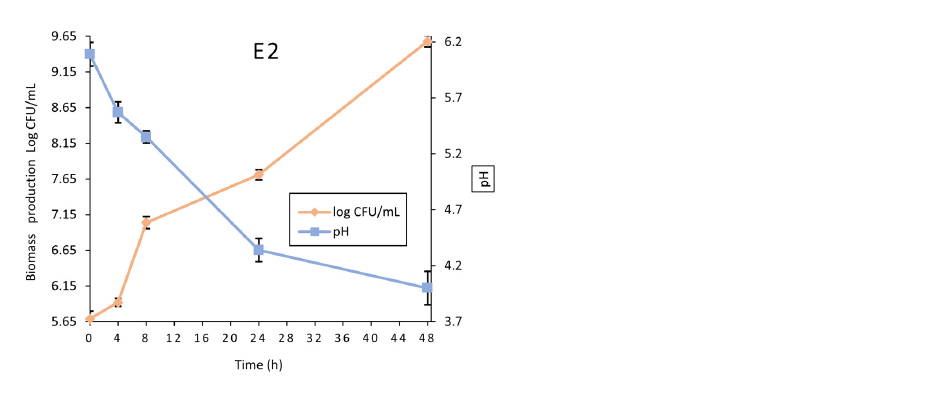
Figure 4. Growth of biomass and pH in fermentation of Lactobacillus paracasei ssp. paracasei (F-19) in Assay E2.